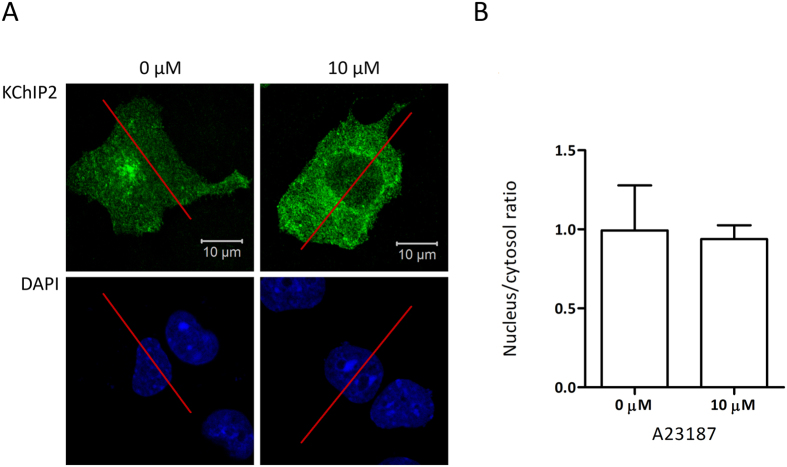
Ca2+ depletion in HL-1 cells.(A) HL-1 cells transfected with KChIP2 cDNA and treated with 0 μM A23187 in a Ca2+-containing medium or 10 μM A23187 in a Ca2+-free medium for 40 min. Pictures showing representative cells stained using a KChIP2 antibody (green). The nucleus is stained blue using DAPI. (B) Quantitative analysis of KChIP2 localization after Ca2+ depletion and the control. Five cells from each transfection (n = 2–3) were chosen for quantification and compared using a Student’s t test.